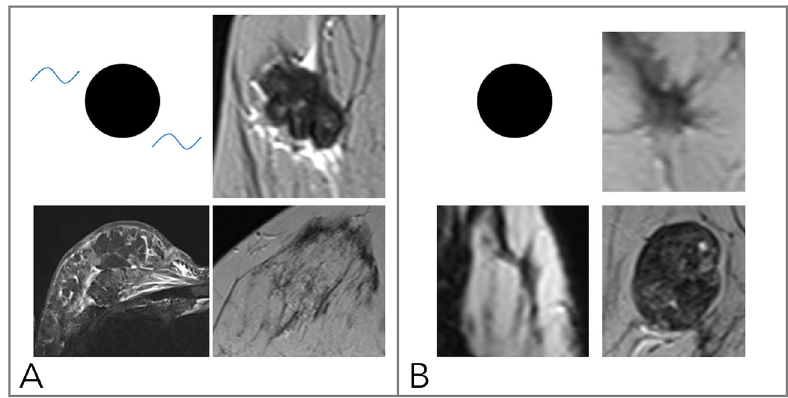
Fig. 6 Diagnostic criteria: oedema. As shown in (A), oedema is present if fluid-caused T2w hyperintensity not attributable to cysts or dilated ducts is identified in the breast that harbours an enhancing lesion. Odema may be perifocal [A, upper right (mass) and lower right (non-mass)] or more diffuse (A, lower left, showing subcutaneous, diffuse, and pre-/